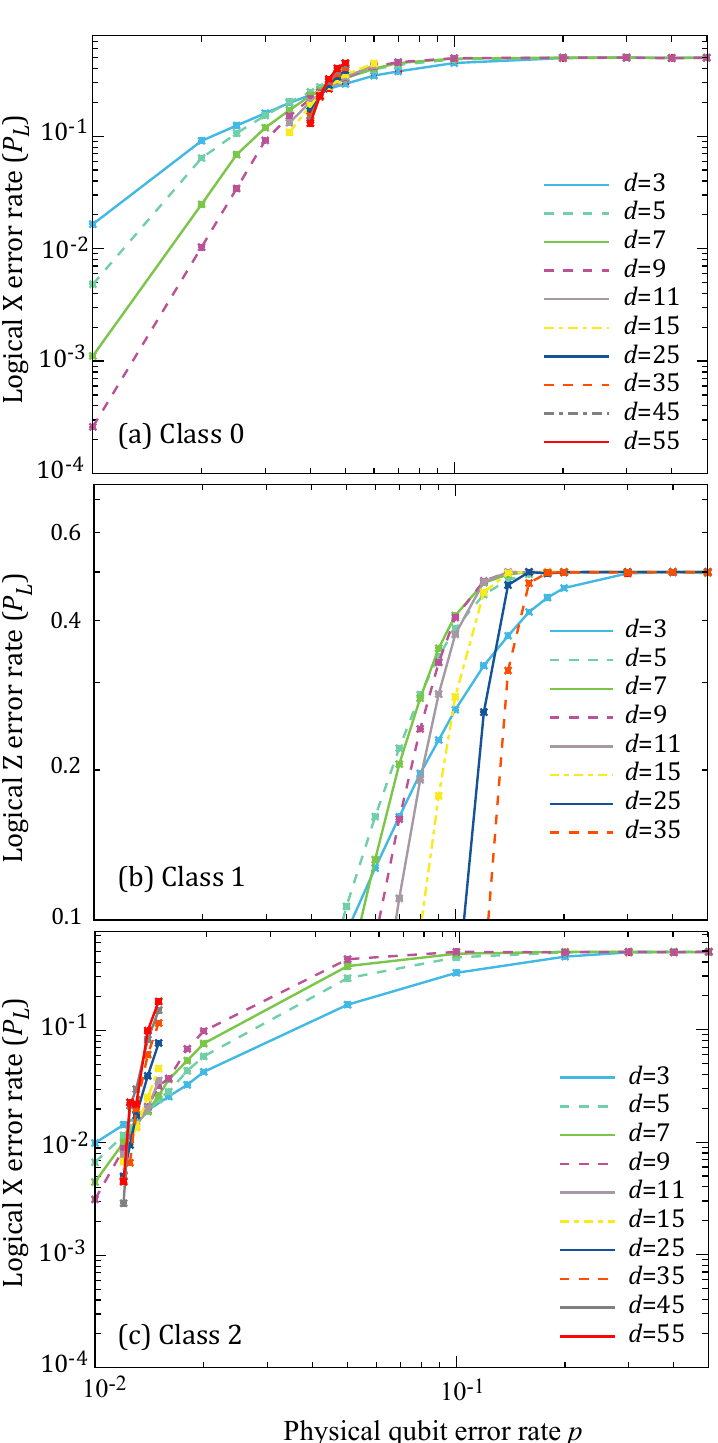
Figure 25: Logical X error rate P per surface code cycle as a function of the per-step physical L L error rate p , considering only (a) class-0 (data qubit) errors, (b) class-1 (measure qubit) errors and (c) class-2 (CNOT) errors. Figure from Ref. (Fowler, Mariantoni, Martinis and Cleland,